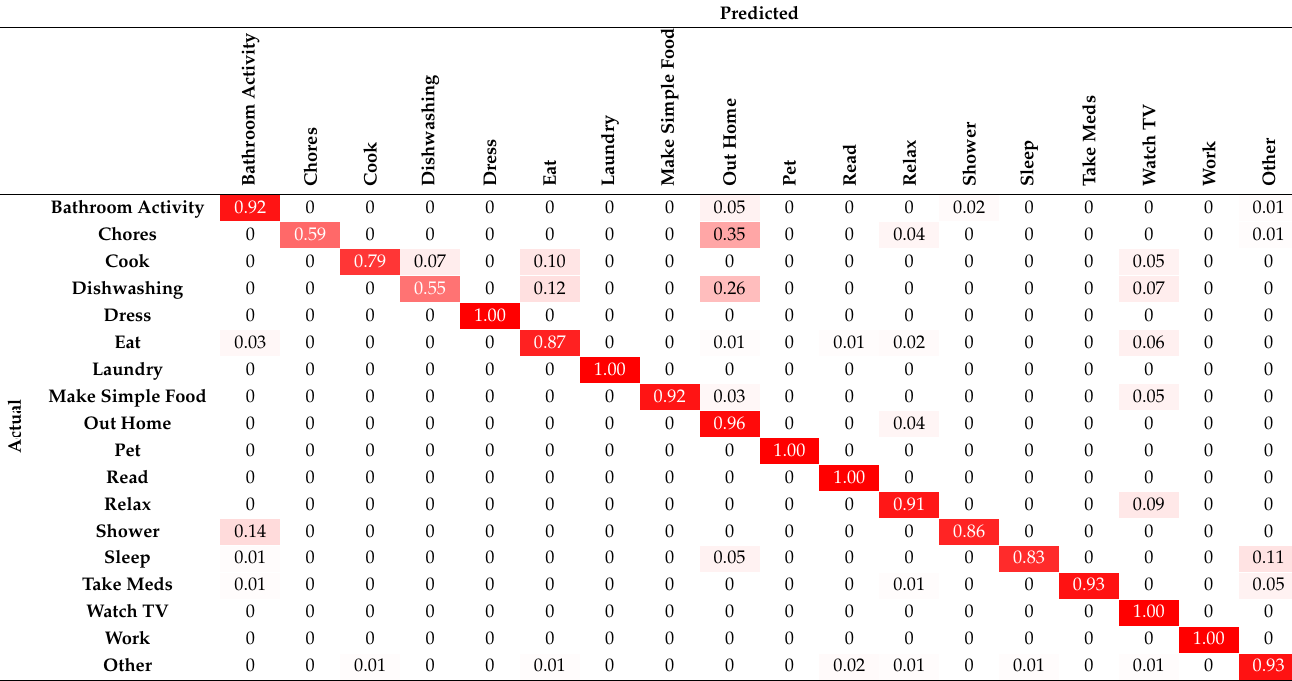
Table 7. Neural network User 1: Confusion Matrix.